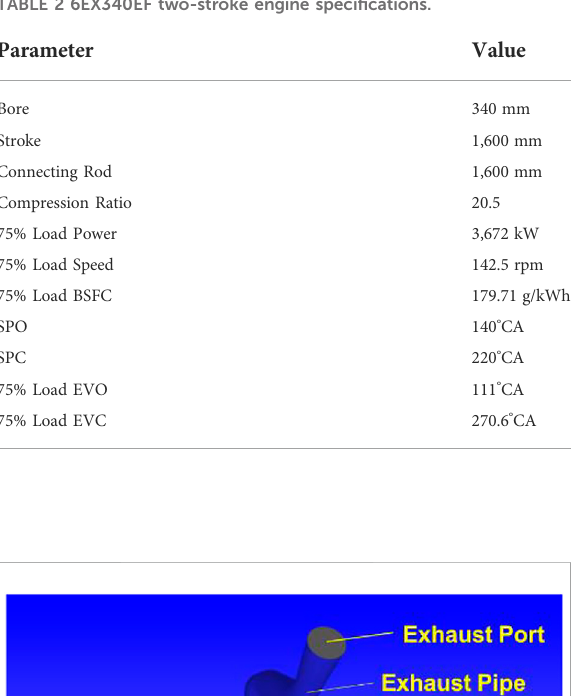
TABLE 2 6EX340EF two-stroke engine speci fi cations.